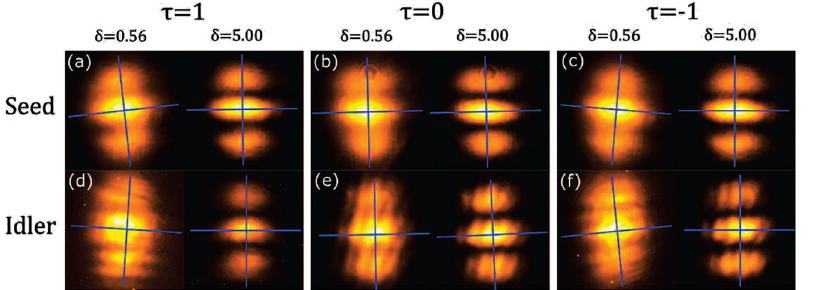
Figure 4: Interference intensity patterns of double-slits compared between two different transverse coherence lengths, 𝛿 = 0 . 56 mm (left in each panel) and 𝛿 = 5 . 00 mm (right in each panel). The coordinate systems represent the rotation angles given in the text. The seed beam (a) undergoes a counterclockwise rotation with normalized twist phase 𝜏 s = 1, (b) does not rotate when 𝜏 s = 0, and (c) undergoes a clockwise rotation with 𝜏 s = − 1. The idler beam, as the phase conjugate of the seed, rotates in the opposite direction. We see in (d) a clockwise rotation when 𝜏 s = 1, (e) close to zero rotation for 𝜏 s = 0, and in (f) a counterclockwise rotation when 𝜏 s = − 1. Table 1: Twist phase of signal and idler beams obtained from the interference patterns shown in Figure 4. Theory ( × 10 3 mm − 1 ) 𝝁 s = 0.40 𝝁 s = 0 𝝁 s = − 0.40 𝜇 × 10 3 mm − 1 ) 0.26 ± 0.04 − 0.02 ± 0.04 − 0.13 ± 0.04 s ( 𝜇 × 10 3 mm − 1 ) − 0.15 ± 0.04 i ( Theory ( × 10 3 mm − 1 ) 𝝁 s = 0.005 𝝁 s = 0 𝝁 s = − 0.005